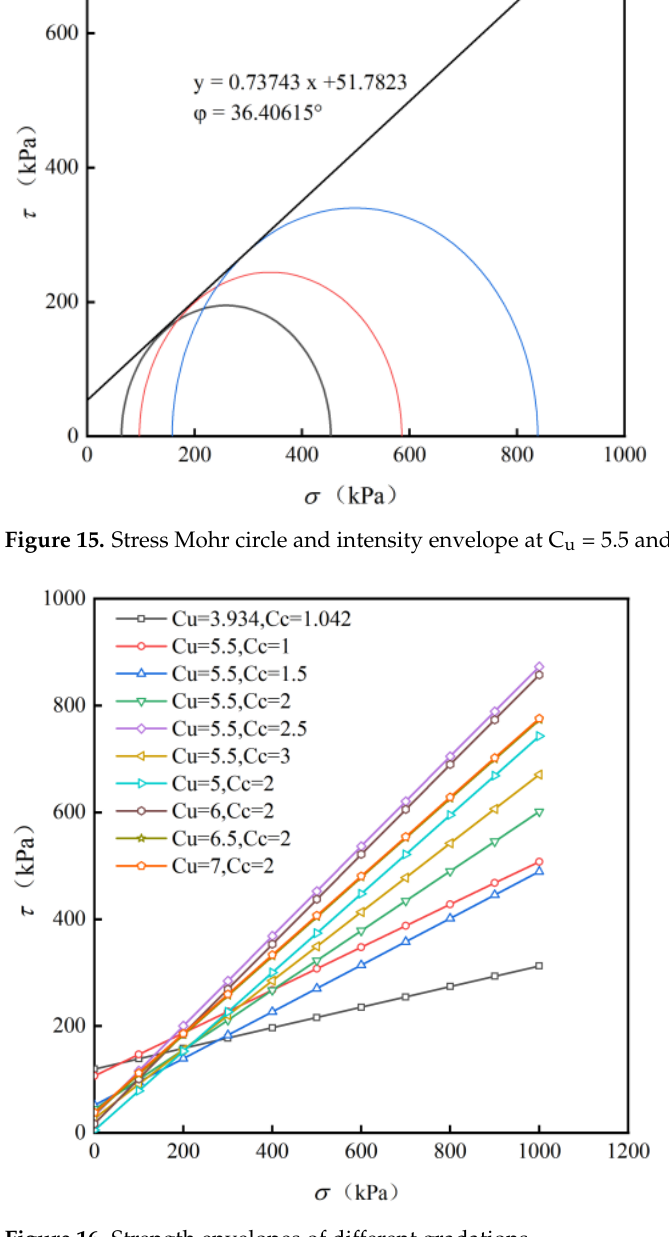
Figure 16. Strength envelopes of different gradations.